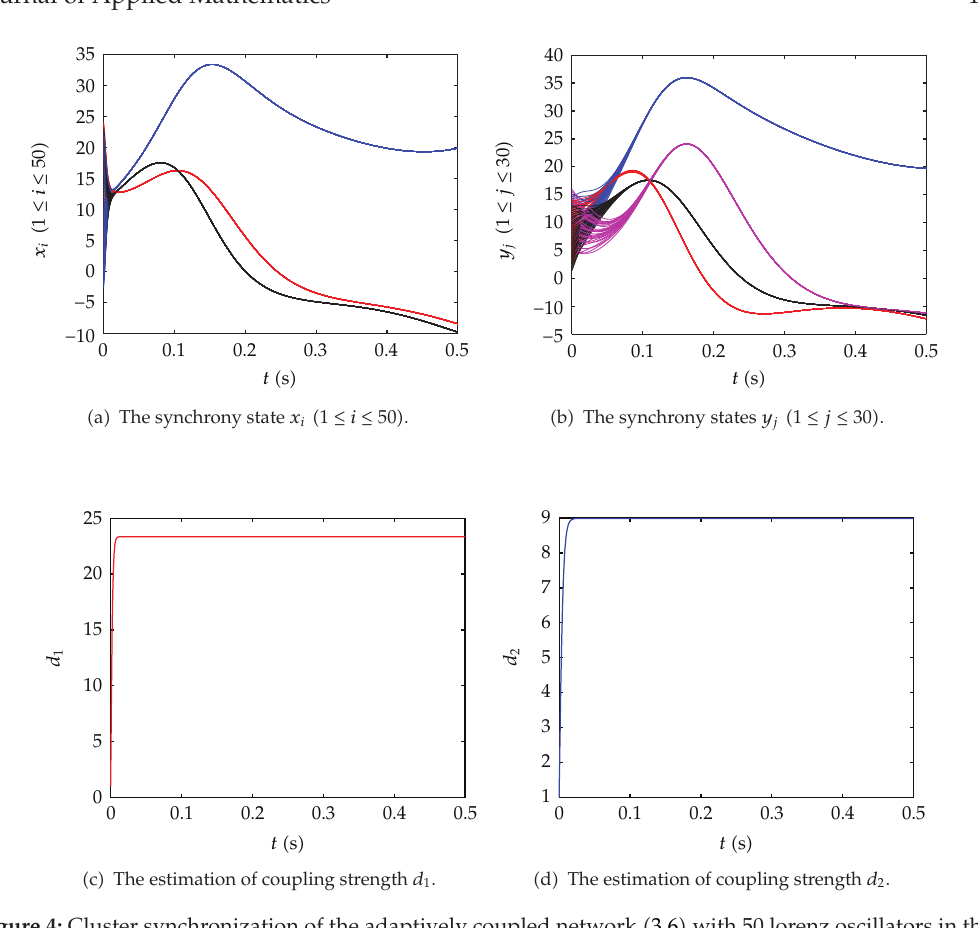
Figure 4: Cluster synchronization of the adaptively coupled network (cid:4) 3.6 (cid:5) with 50 lorenz oscillators in the x -cluster and 30 hyperchaotic L¨u oscillators in the y